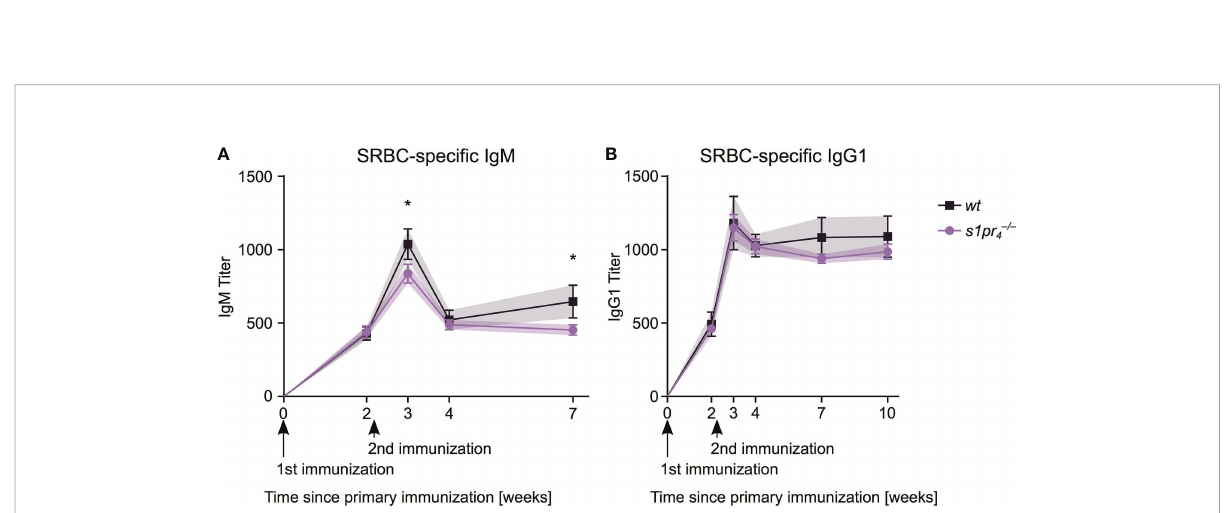
FIGURE 6 SRBC-speci fi c antibody response after intraperitoneal immunization. Mice of both genotypes were immunized by intraperitoneal injection of sheep red blood cells (SRBC) at days zero and fourteen. SRBC-speci fi c antibody response was analyzed after retro-orbital puncture at days 0, 14, 21, 28 and 49 for IgM (A) and additionally at day 70 for IgG1 (B) . Data shown for n = 5 animals per genotype. Values represent mean ± SD. * p < 0.05.